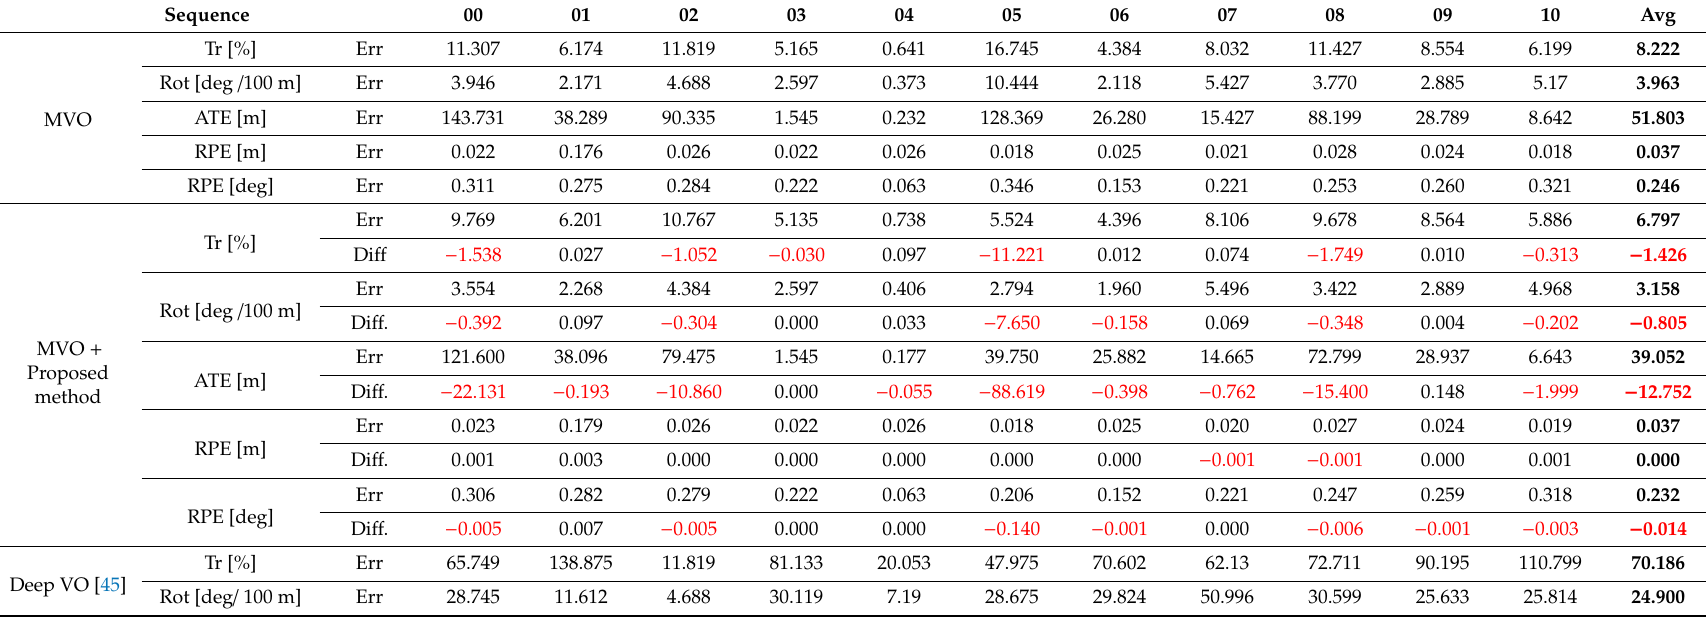
Table 1. Simulation results obtained for the KITTI sequences 00 to 10. The value marked in red is the amount of reduced